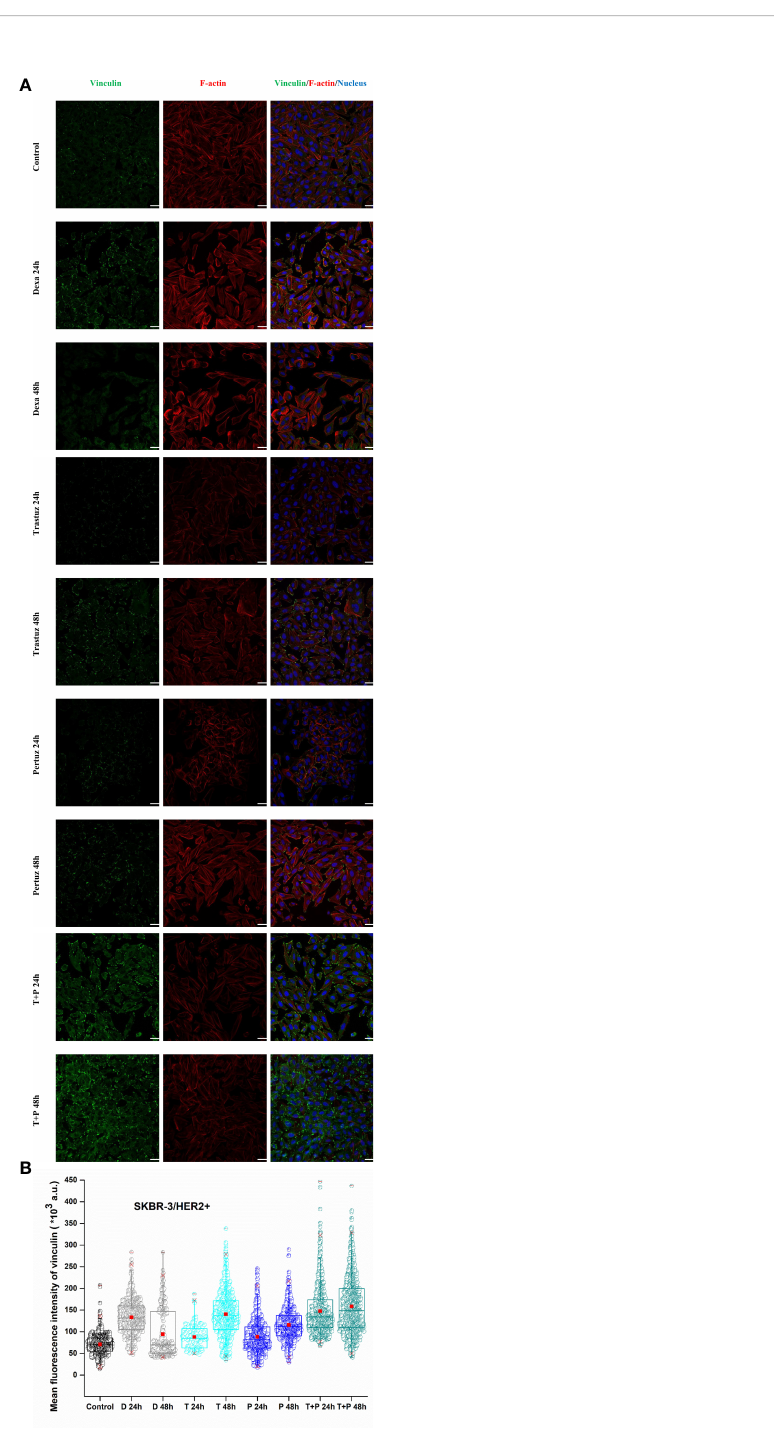
FIGURE 8 Effect of trastuzumab, pertuzumab, and their synergistic effect for double inhibition of HER2 + cancer cells on vinculin expression levels and merge plot of vinculin, F-actin, and nucleus, white color scale bar 40 m m, ×40 microscope confocal lens (A) . After detachment, SKBR-3 cancer cells were incubated with monoclonal antibodies, trastuzumab and/or pertuzumab for 24 h and 48 h. Quantitative confocal microscopy analysis via ImageJ displays the mean fl uorescence intensity of vinculin. Mean values ± SD of mean immuno fl uorescence intensity of 400 cells per treatment with three independent experiments are represented re fl ecting Control, dexamethasone as positive control (D 24 h, D 48 h), trastuzumab (T 24 h, T 48 h), pertuzumab (P 24 h, P 48 h), and their synergistic effect (T + P 24 h, T + P 48 h). Box-plot whiskers represent the 5th and 95th percentile, the median value is represented by the line within the box, and the red square box depicts the mean (B)